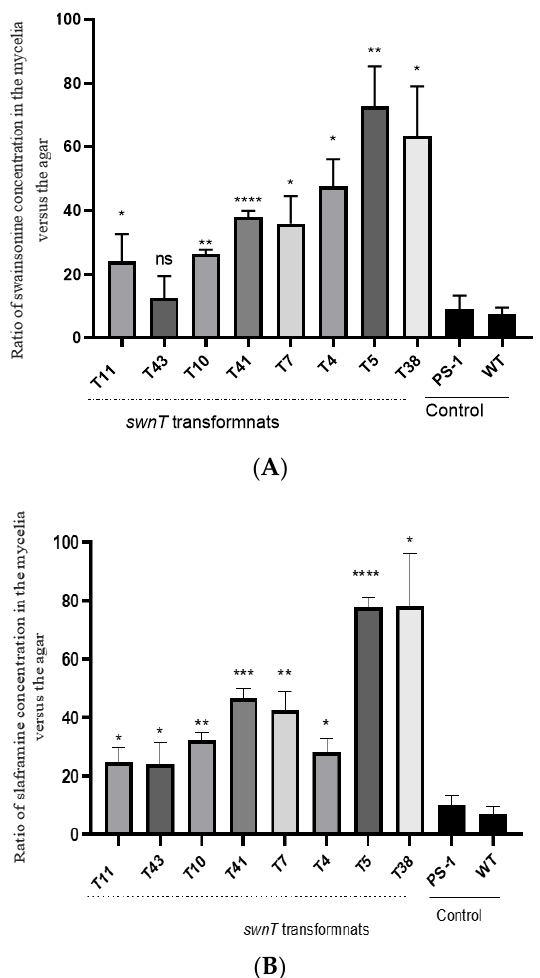
Figure 5. Biochemical analysis of ( A ) swainsonine and ( B ) slaframine (LC–MS) in the pSilent- swnT transformants. Data are expressed as ratios of the ( A ) swainsonine and ( B ) slaframine concentrations in the mycelia versus the agar between the pSilent- swnT transformants, PS-1 S. leguminicola transformed with empty vector (pSilent-1), and WT S. leguminicola . Significant differences in the ratios were observed between the transformants and the controls. Transformants T5 and T38 showed the highest ratio compared with the control. Error bars represent the ± SEM ( n = 3), p values are calculated using unpaired Student’s t test compared with WT (* p ≤ 0.05, ** p < 0.01, *** p < 0.001, **** p < 0.0001, ns = not significant p > 0.05).